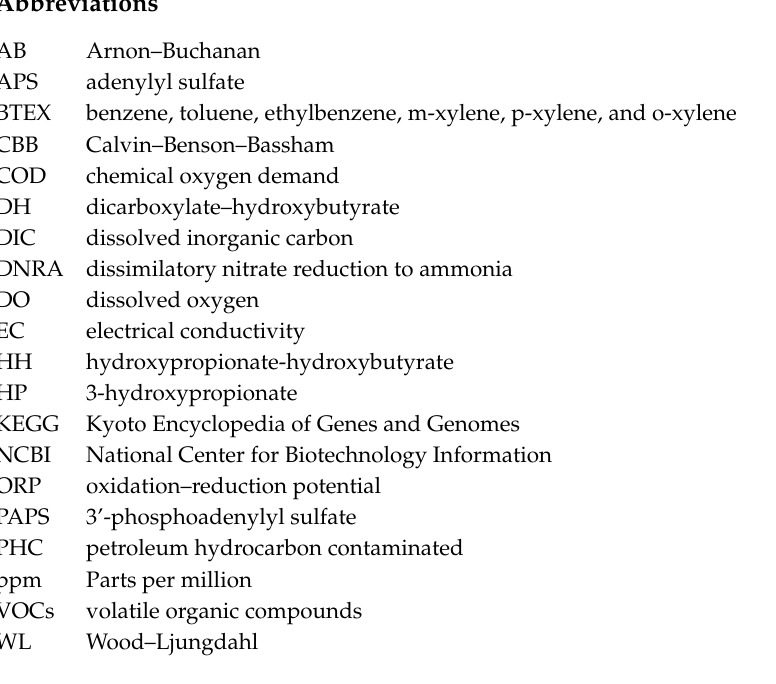
Figure S1: Gene abundances involved in carbon fixation, nitrate reduction and sulfate reduction, Figure S2: Microorganisms involved in carbon fixation (in Genes level), Figure S3: Microorganisms at genes level in each step of assimilatory reduction and oxidation, Figure S4: Microorganisms at genes level in each step of dissimilatory reduction and oxidation, Table S1: Abundances (ppm) of genes encoding enzymes involved in carbon